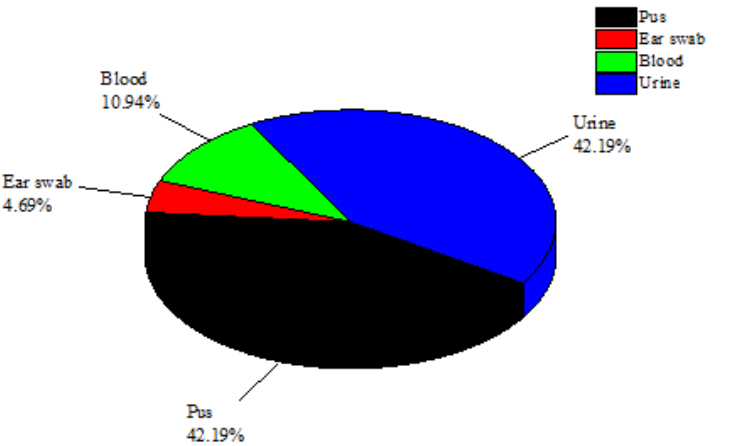
Figure 1. S. epidermidis prevalence (number and percentage) in various clinical infection samples. In total, 64 S. epidermidis isolates were screened for MRSE and MSSE based on the types of samples and places where the specimens were collected (Table 1). Of them (N=64), 38 recovered S. epidermidis isolates were MRSE and 26 were MSSE. The highest concentra- tions of MRSE and MSSE were found in urine and pus samples, respectively. Table 1. Distribution of MRSE and MSSE based on clinical specimens. Source of Specimen